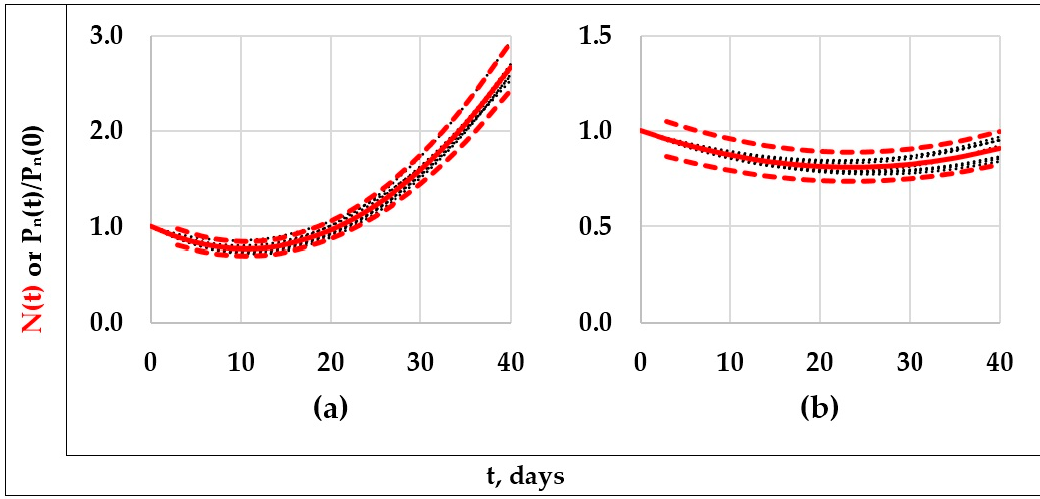
Figure 5. “Master curves” (continuous lines in red) considered as representative for the systems F1-P1 ( a ) and F2-P3 ( b ), their respective limiting curves (dotted-lines in red) denoting a deviation of ± 10% with respect to its correspondent “master curve” and the respective P n ( t ) / P n ( 0 ) vs. t curves (dotted-lines in black).